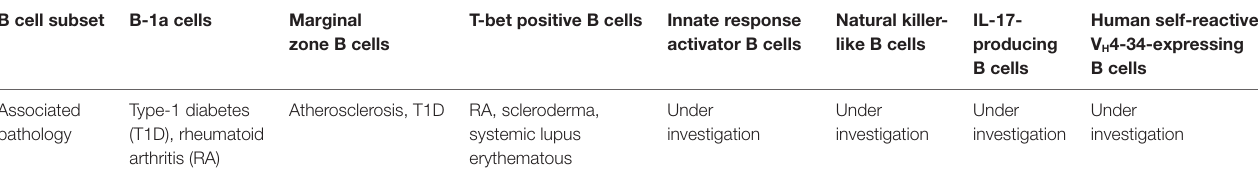
TABLe 3 | Principal B cell subsets with innate-like